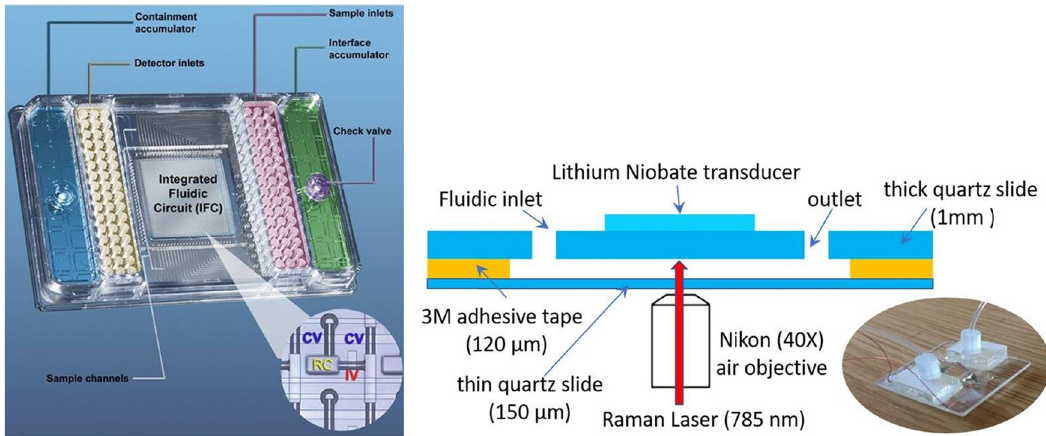
Figure 3: Left: Picture of the high - throughput ( 48 × 48 array ) micro fl uidic device used in ref. [ 32 ] ( developed in ref. [ 33 ]) for the tran - scriptomic pro fi ling for speeding drug development programs. The sample and reagents are introduced through the inlets, which are pressure - driven through valves to the integrated fl uidic circuit, composed of fl uid lines, valves, and microchambers in which the PCR takes place. Right: Cross - sectional view and picture of the chamber of the Raman platform developed in ref. [ 34 ] . Cells go through silicone tubes into a trapping chamber of quartz. Then, acoustic pressure is applied through a lithium transducer to make them levitate and aggregate to determine the Raman spectra. Images reproduced with permission from PLoS ( left, [ 33 ]) and Communications Biology ( right, [ 34 ])